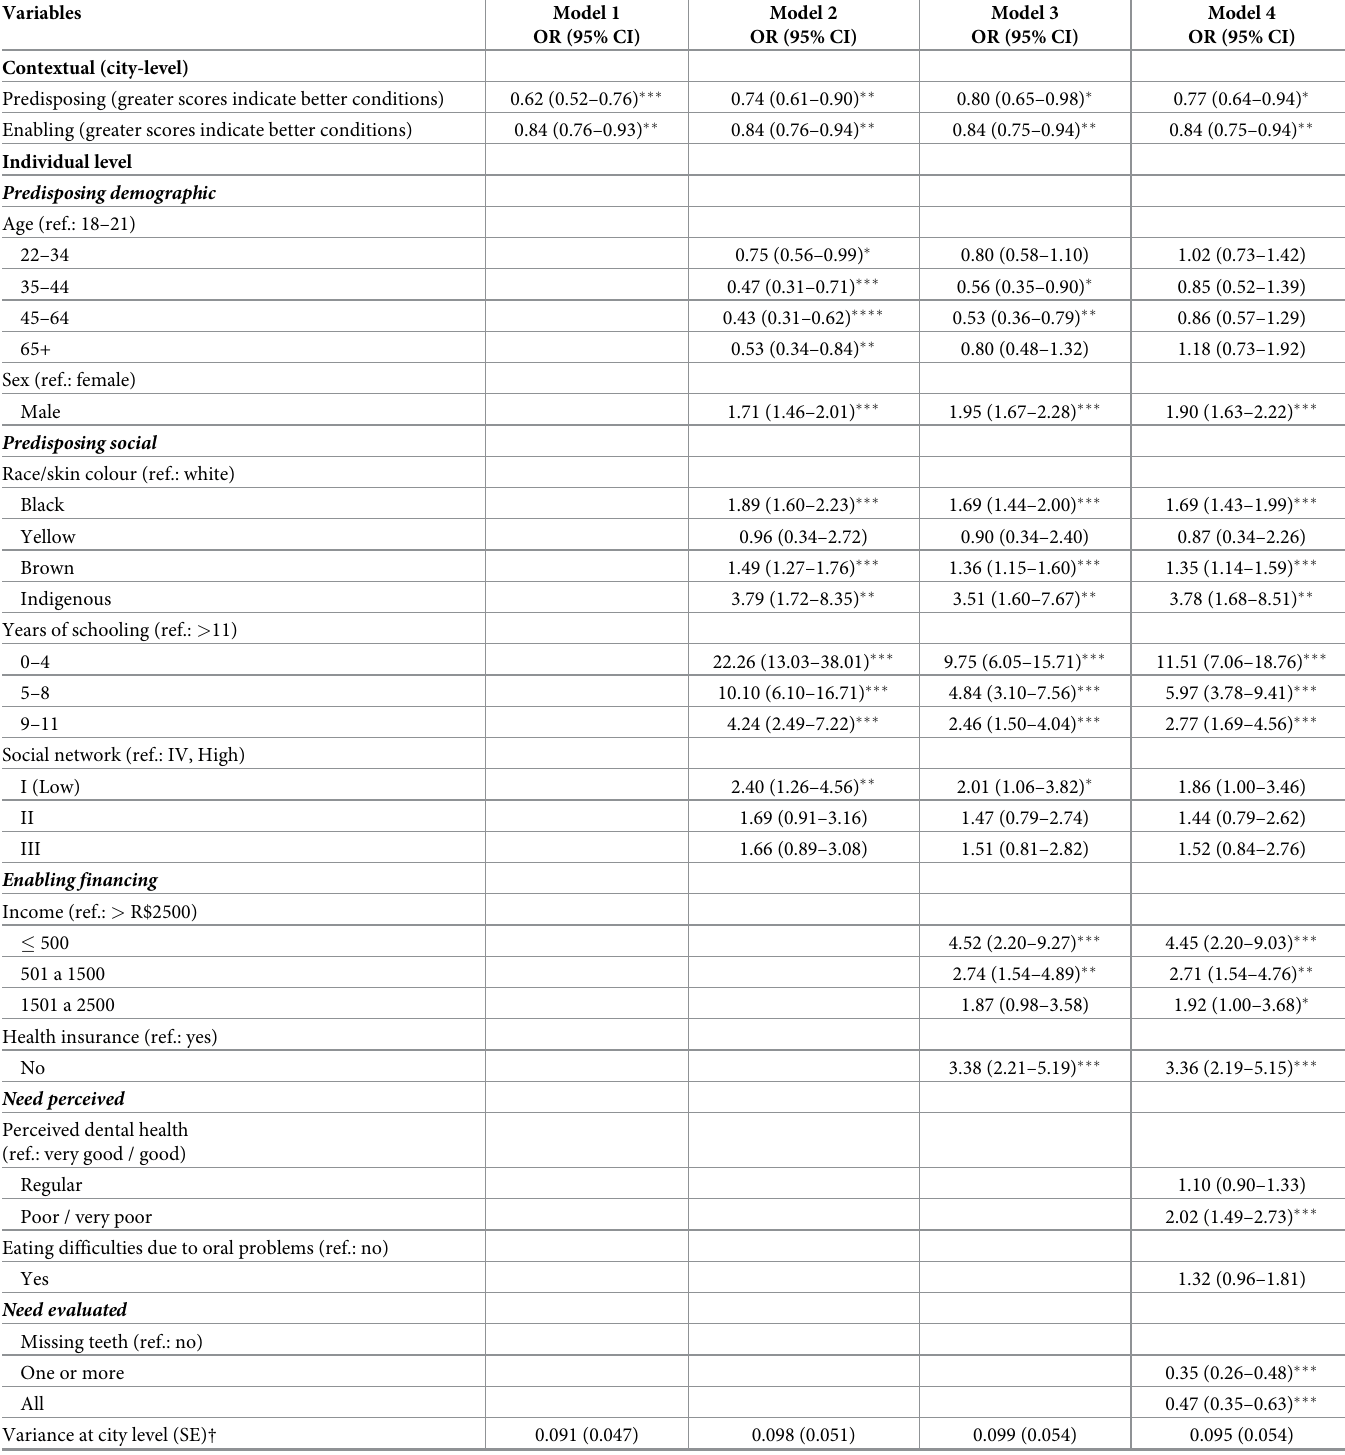
Table 4. Hierarchical multilevel analysis for non-utilisation of dental services, Brazil, State capitals, 2013 (n =